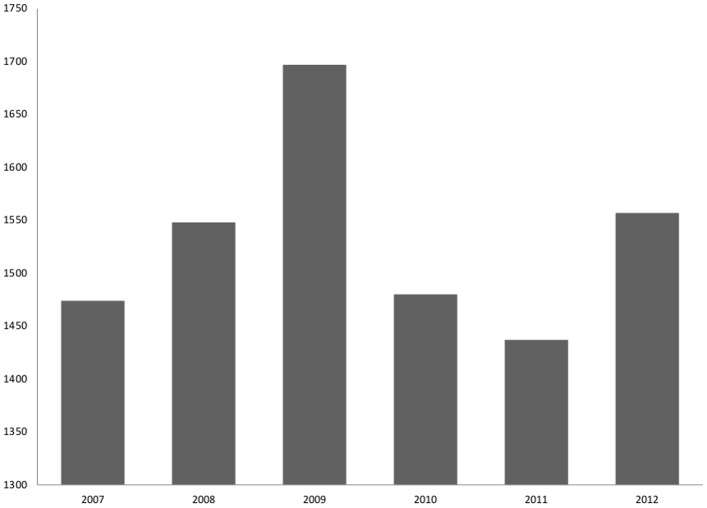
Absolute number of snakebite envenomings in the state of Amazonas, reported by year, from 2007 to 2012.Incidence was slightly higher in 2009 (1,697 cases; 58.5 per 100,000 inhabitants) and 2012 (1,558 cases; 53.7 per 100,000) and lower in 2011 (1,436 cases; 49.5 per 100,000).